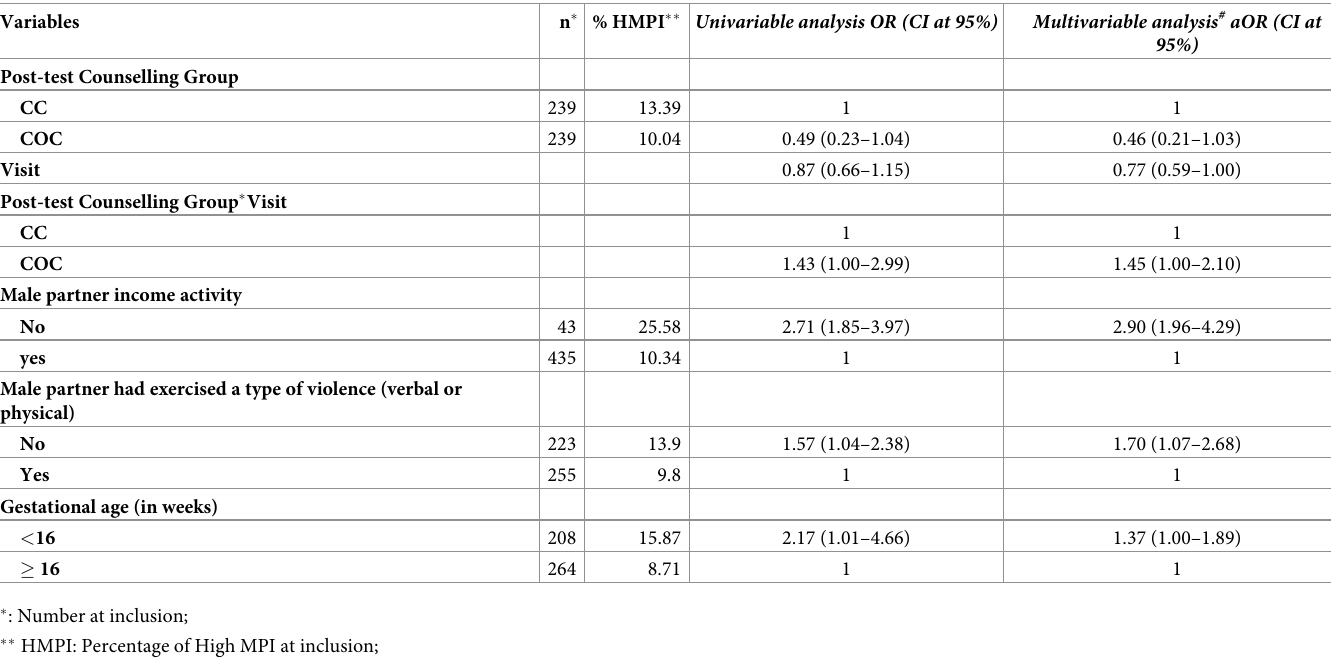
Table 2. Factors associated with the evolution of high MPI in the couple’s sexual and reproductive health, ANRS trial 12127–12236 Prenahtest, Cameroon, 2009– 2011. Variables Multivariable analysis # aOR (CI at